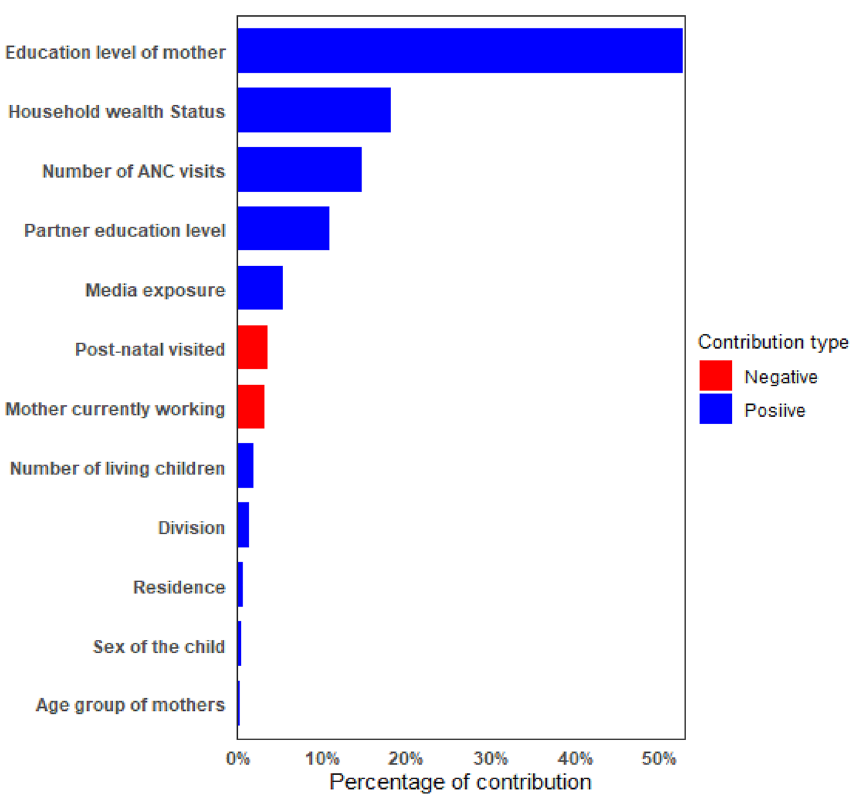
Figure 5. Percentage of contribution of variables on the Concentration Index of dietary diversity resulting from education